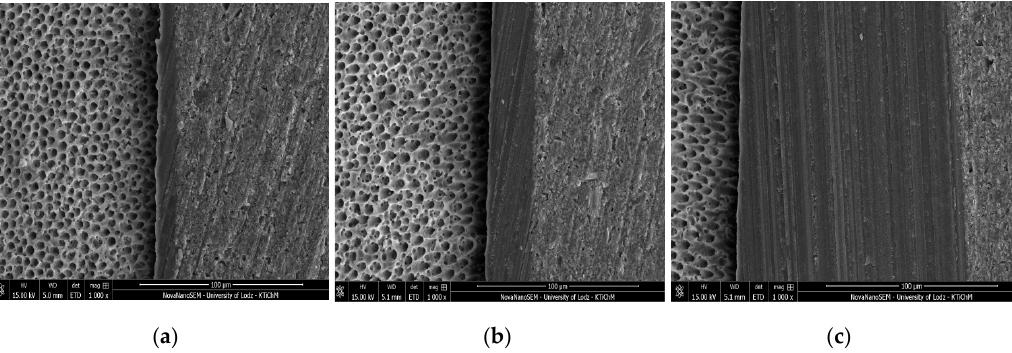
Figure 1. SEM images of adhesive layers obtained by application of Adper Easy One: ( a ) one layer; ( b ) two layers; ( c ) three layers; mag. 1000x.